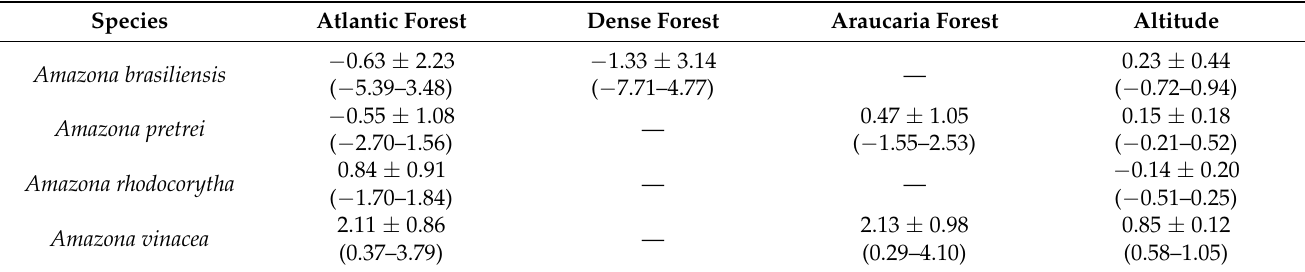
Table 2. Coefficients of the occupancy equation in each species model. The numbers show the mean ± standard deviation and 95% credible intervals (in parentheses) of the a posteriori distribution of each